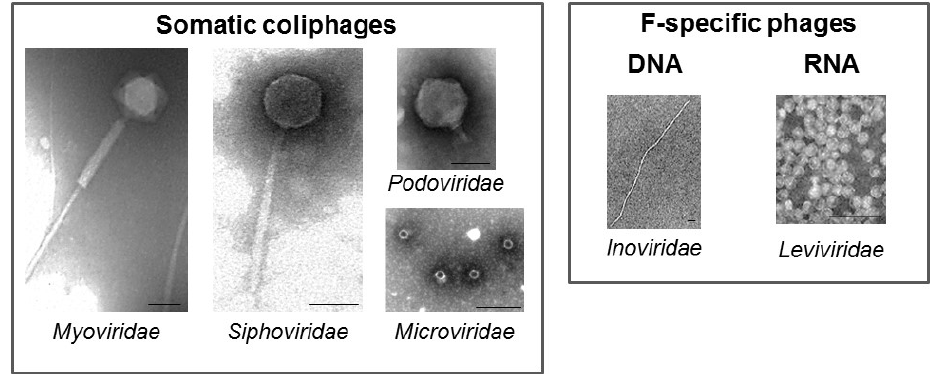
Figure 1. The most common morphological types in somatic coliphages and F-specific phages. Bar 50 nm.